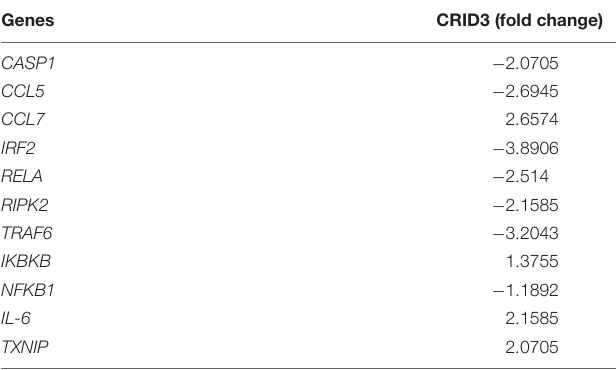
TABLE 2 | Cytokine release inhibitory drug (CRID3) inhibits inflammasome associated genes